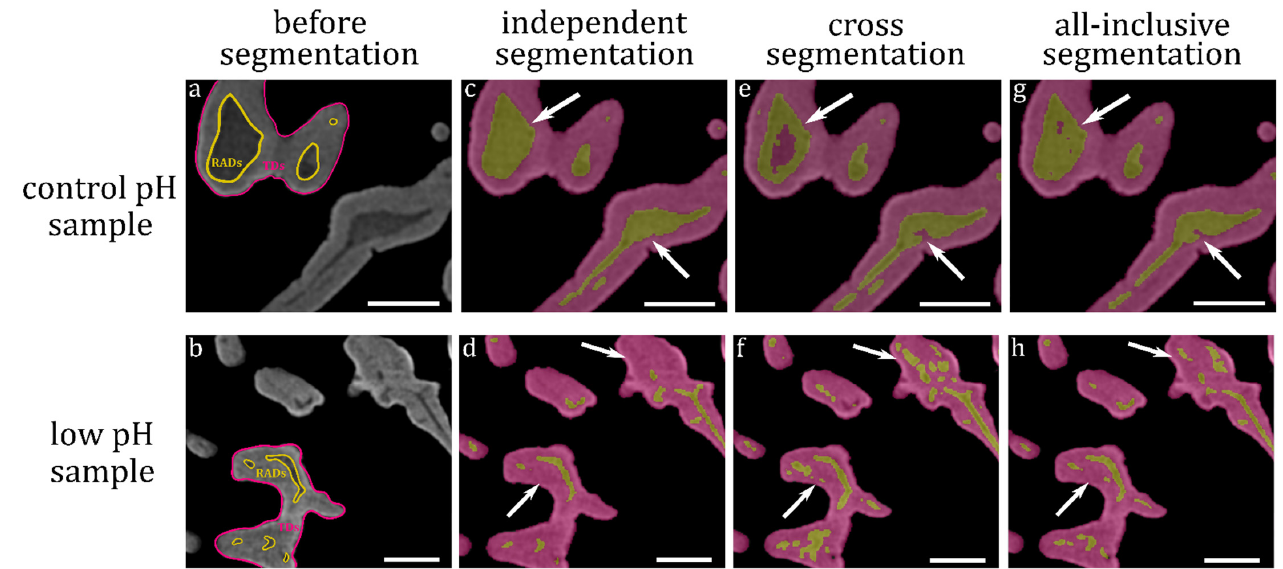
Figure 7. Evaluation of the DL-based segmentation performance. ( a , b ) Details of the skeletal structures in representative coral recruits from the control and low pH conditions before applying the DL-based segmentation (ground truth images). RADs and TDs in example areas have been manually delineated in yellow and pink, respectively. ( c , d ) Segmentation of RADs and TDs based on training a network independently per each single dataset. Specifically, ( c ) shows the outcome of the segmentation of network A trained and applied on dataset A (a representative control pH sample), whereas ( d ) shows the outcome of the segmentation of network X trained and applied on dataset X (a representative low pH sample). ( e ) Segmentation obtained by employing a DL network that was trained using dataset B (another representative control pH sample) and applied to dataset A. The white arrows point to mismatches in the segmentation as compared to the more accurate segmentation in ( c ). Note how RAD regions have been segmented as TDs. ( f ) Segmentation obtained by training the DL network on dataset A and using it to segment dataset X. The white arrows point to mismatches in the segmentation as compared to the correct segmentation in ( d ). ( g , h ) Segmentation obtained by employing a DL network that was trained using all tomographic datasets (all 6 datasets from both control and pH conditions). White arrows identify example points where different segmentation is seen in ( g ) as compared to ( e ), and the better segmentation in ( h ) as compared to ( f ). Scale bars: 100 µ